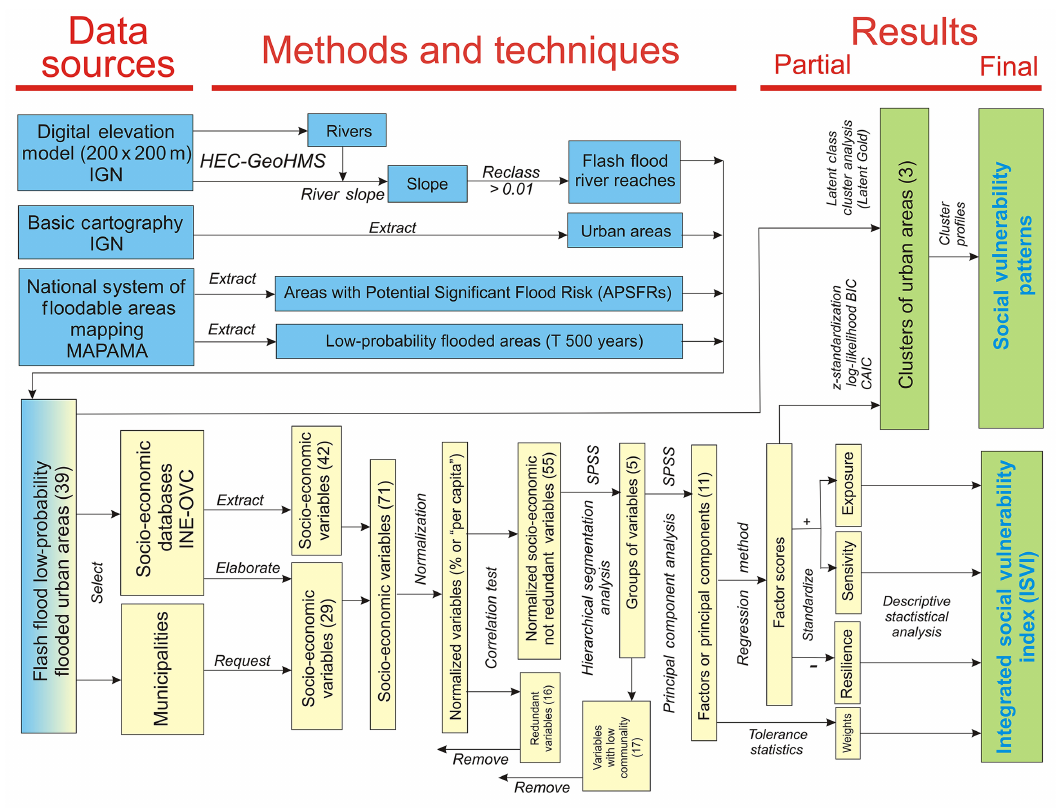
Figure 2. Methodological outline containing the different steps followed in the construction of the ISVI and the social vulnerability